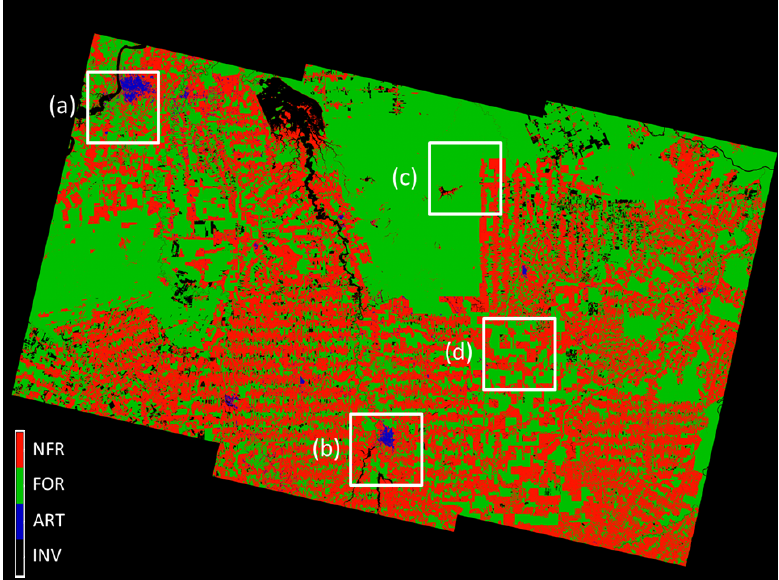
Figure 5. Classification map of the stack number 7 summarized in Table 2. Black: invalid pixels (INV), blue: artificial surfaces (ART), green: forests (FOR), red: non-forested areas (NFR). White polygons delimit four patches of 512 × 512 pixels used for the classification accuracy analysis. They are named (a), (b), (c), and